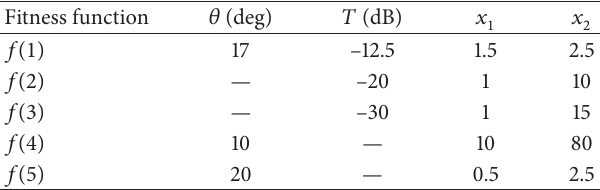
Table 3: Goal values of the fitness function. Fitness